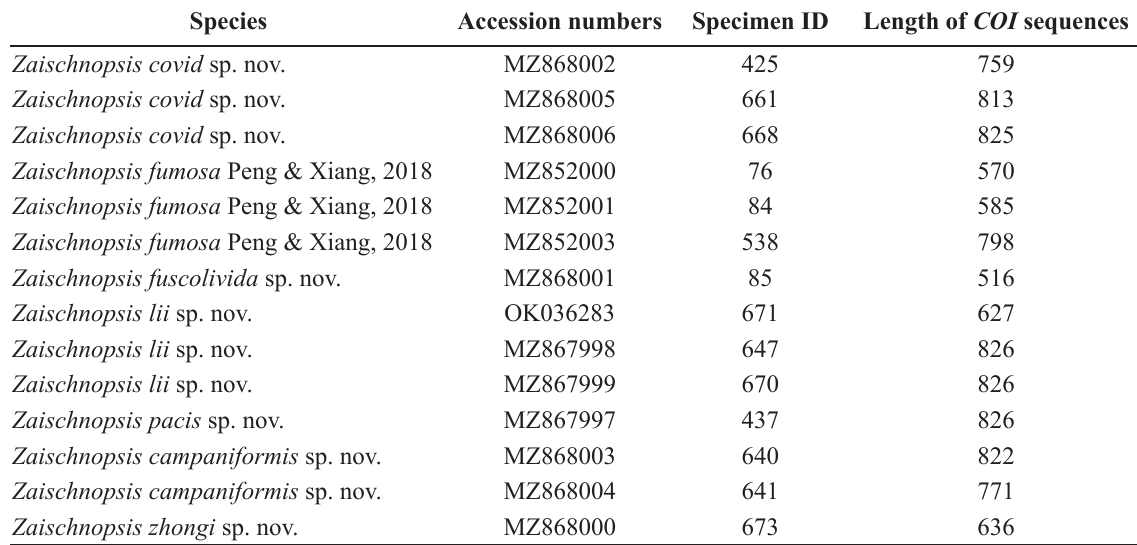
Table 1. Accession numbers and length of COI sequences of species in Zaischnopsis Ashmead, 1904.